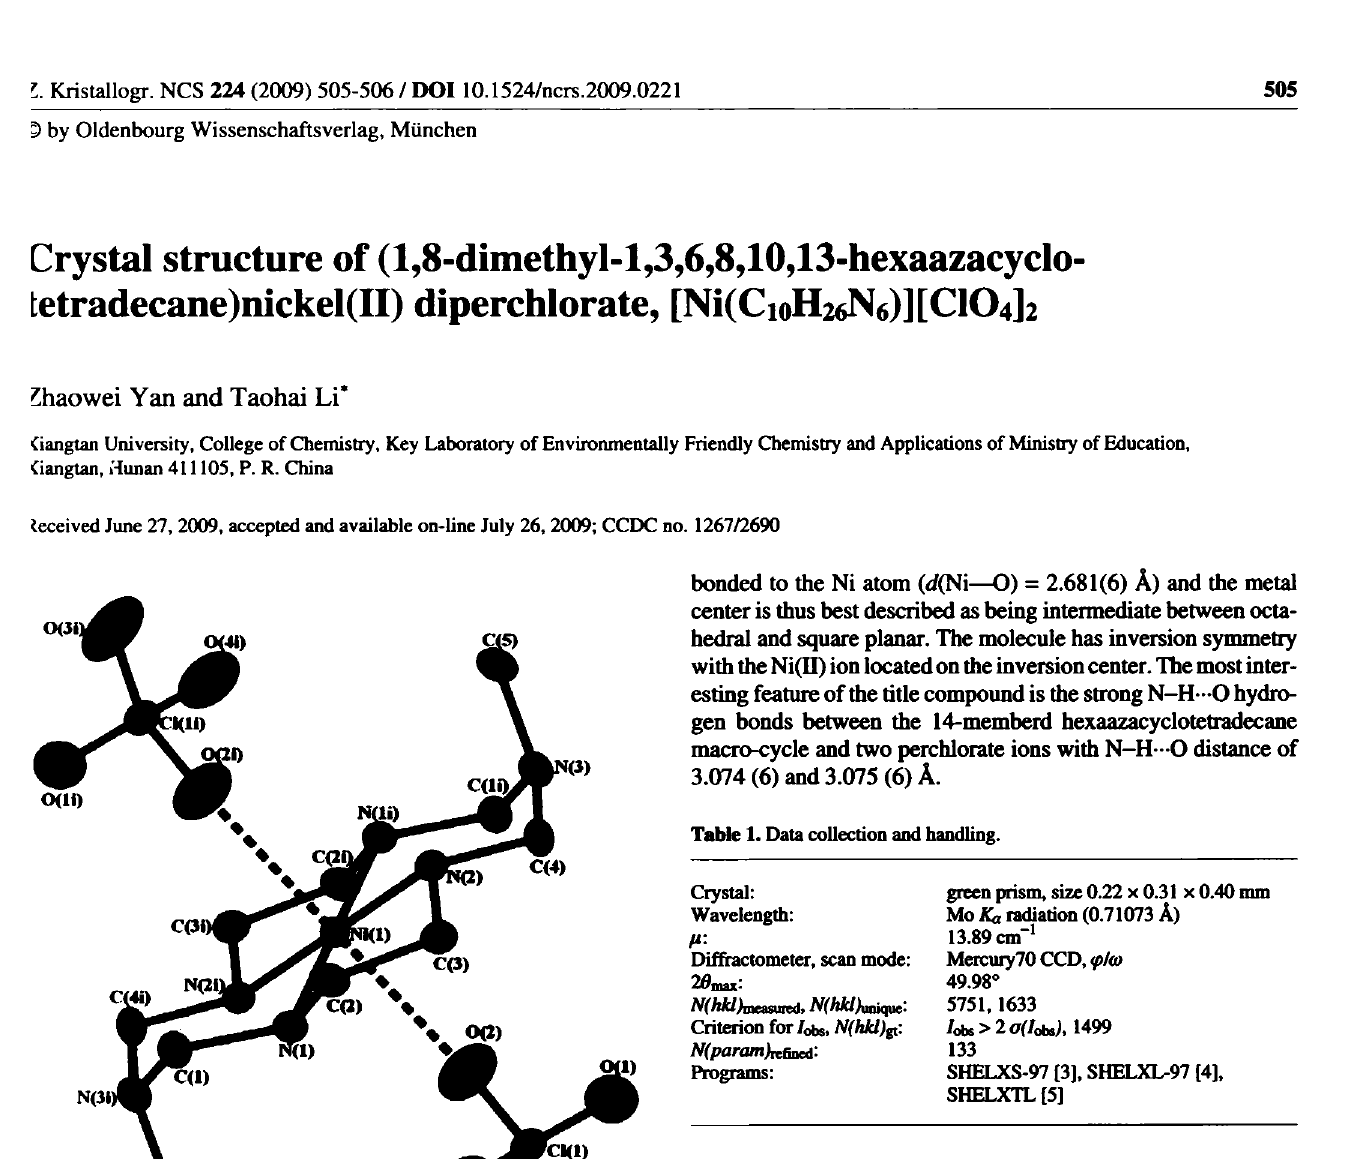
Table 2. Atomic coordinates and displacement parameters (in Â 2